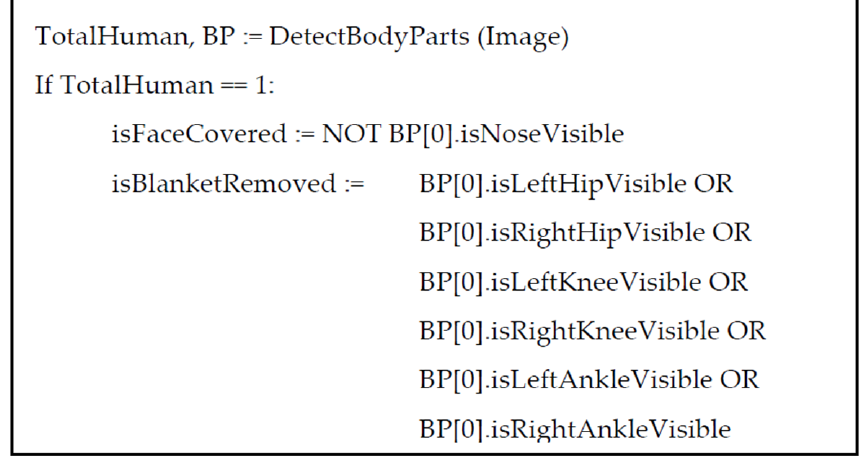
Figure 4. Pseudocode for a face covered and blanket removed detection.